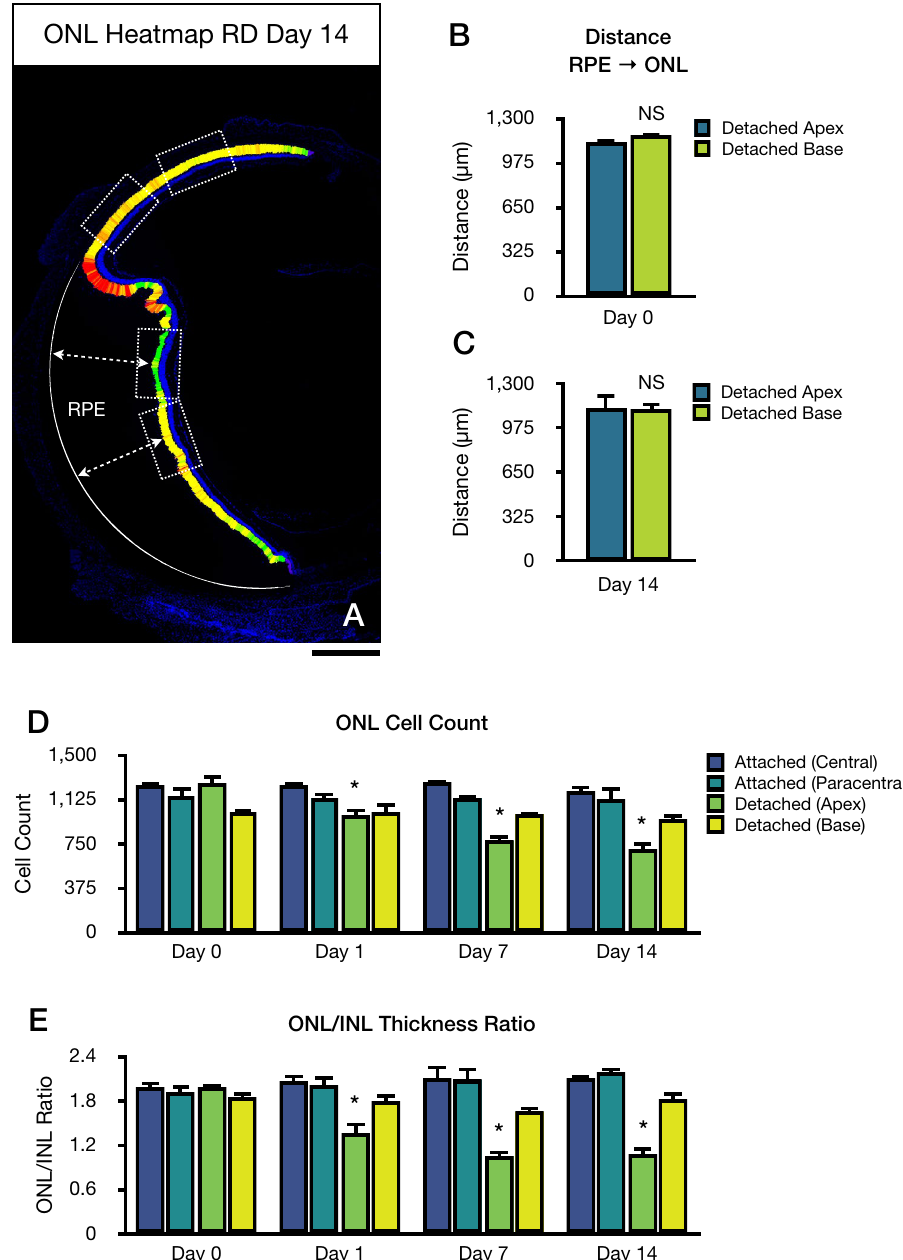
Figure 2. Progressive outer nuclear layer (ONL) degeneration following retinal detachment. ( A ) Representative cryosection whole-retina tile image of a retinal detachment relative ONL thickness heatmap. Regions of interest used for analysis (dotted boxes), and retinal detachment height callipers (dashed arrows). ( B ) Height of retinal detachment at baseline. ( C ) Height of retinal detachment at day 14. ( D ) ONL cell count analysis. ( E ) ONL/INL thickness ratio analysis. Scale bar = 400 µm ( A ). * p < 0.05 vs. baseline day 0 between groups (n =